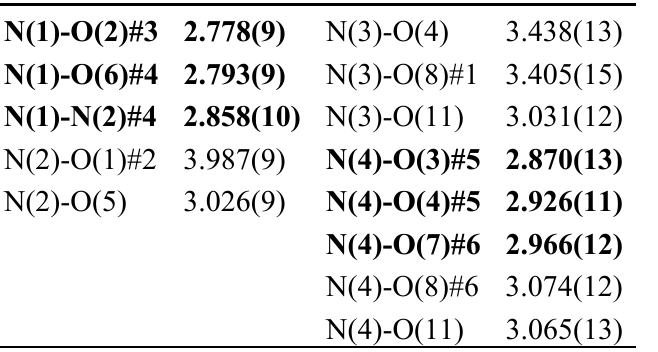
Table 3. Selected interatomic distance (Å) for 1 . The distances shorter than 3.0 Å are represented in bold font.